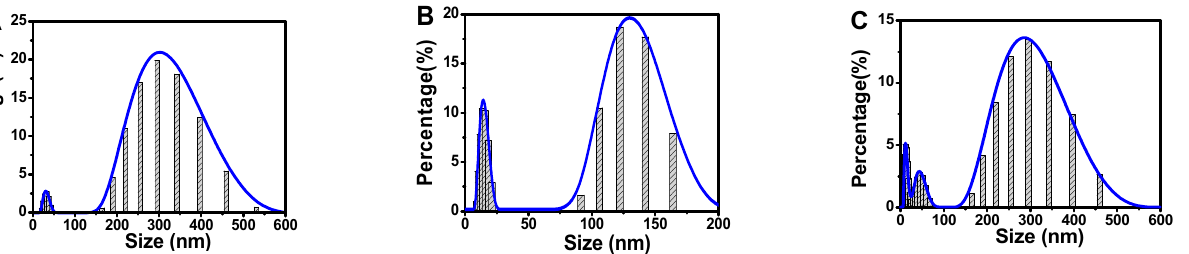
DLS sizes were greater than the sizes obtained from SEM image because the size obtained from DLS was the hydrated particle size including molecules around particles.